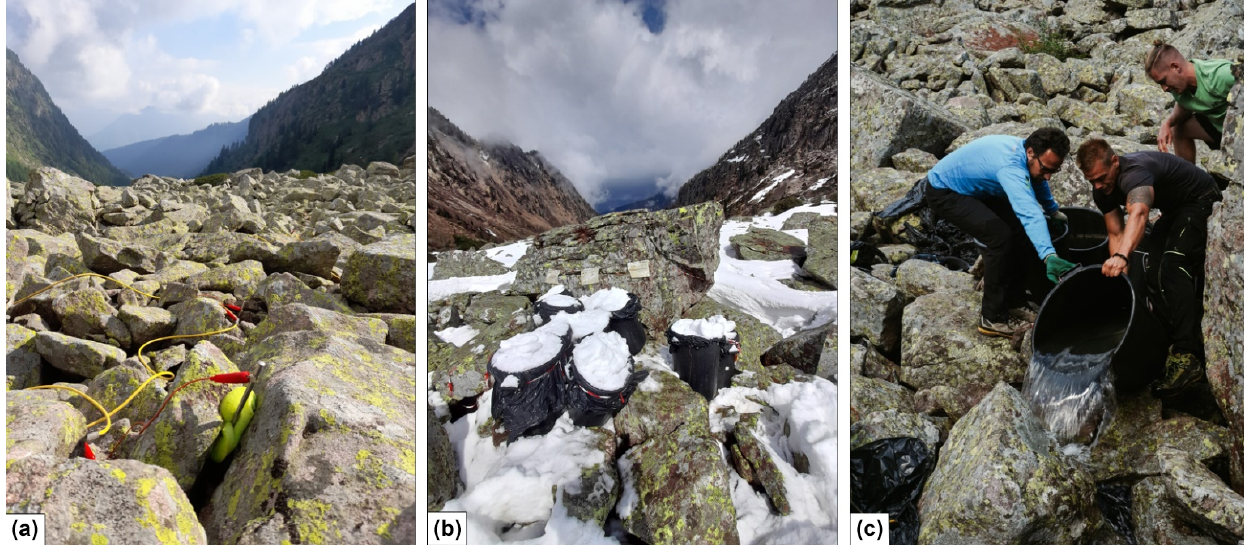
Figure 2. (a) Electrodes inserted between the boulders using sponges soaked with saltwater to improve the contact resistances of the ERT surveys; (b) 10 bins placed at the selected injection point in early spring 2022, filled with snow and covered with nylon sheets pierced at their center to collect rainwater; (c) injection of 800L of salt water into the subsurface